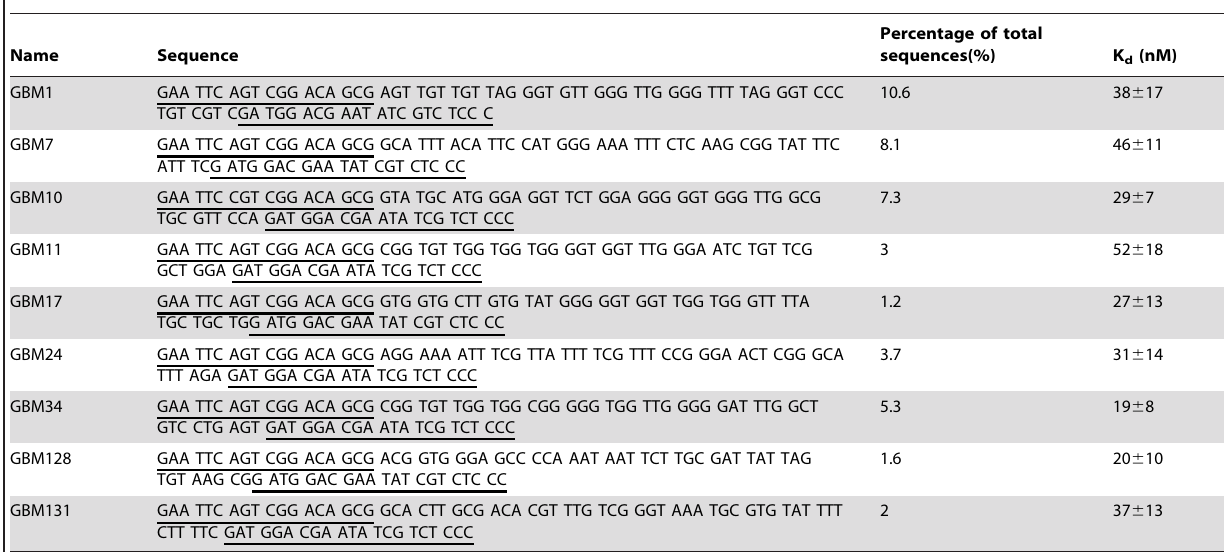
Table 1. Aptamer sequences and their dissociation constants (K d